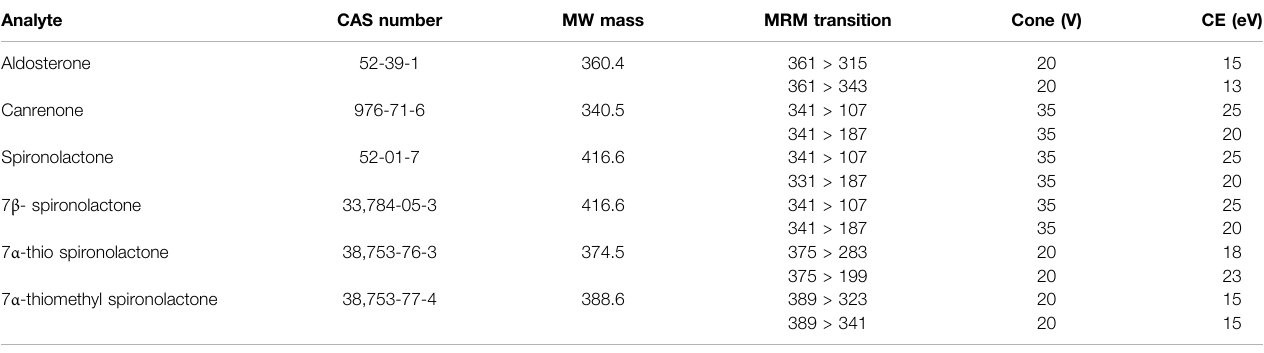
TABLE 1 | MRM transitions, cone and collision energy of target mineralocorticoids.